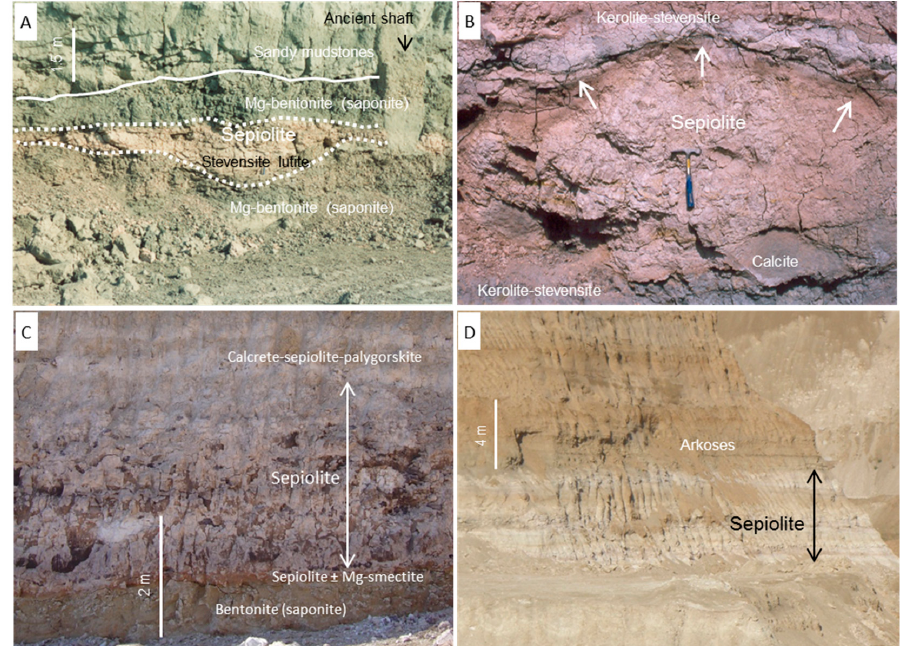
Figure 5. Representative field photographs of Mg-clay assemblages in different environments of the Madrid Basin. ( A ) Mud flat lithofacies (saponite-stevensite-sepiolite). ( B ) Mud flat lithofacies (kerolite-stevensite mixed layers-sepiolite). ( C ) Palustrine lithofacies (saponite-sepiolite-palygorskite). ( D ) Alluvial fan lithofacies (sepiolite).